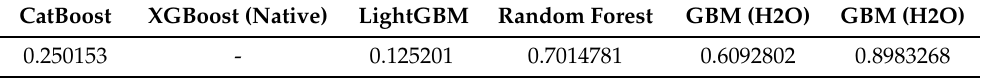
Table 8. The p -value of Quade post-hoc, in which XGBoost (native) is used as a control algorithm. CatBoost XGBoost (Native) LightGBM Random Forest GBM (H2O) GBM (H2O) 0.250153 - 0.125201 0.7014781 0.6092802 0.8983268